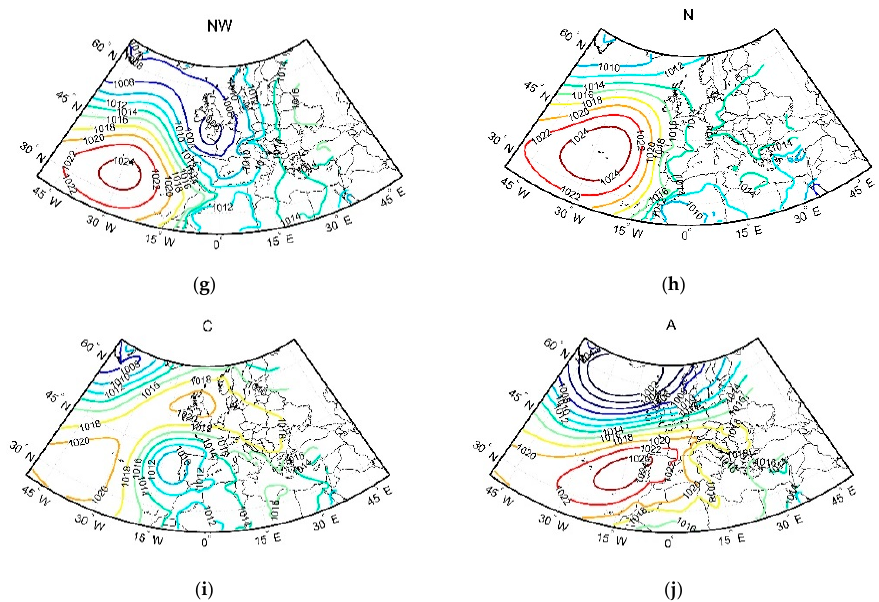
Figure 2. The ERA-Interim mean sea level pressure for each of the 10 weather types in 1979–2011: ( a ) north (N), ( b ) northeast (NE), ( c ) east (E), ( d ) southeast (SE), ( e ) south (S), ( f ) southwest (SW), ( g ) west (W), ( h ) northwest (NW), ( i ) cyclonic (C) and ( j ) anticyclonic (A).